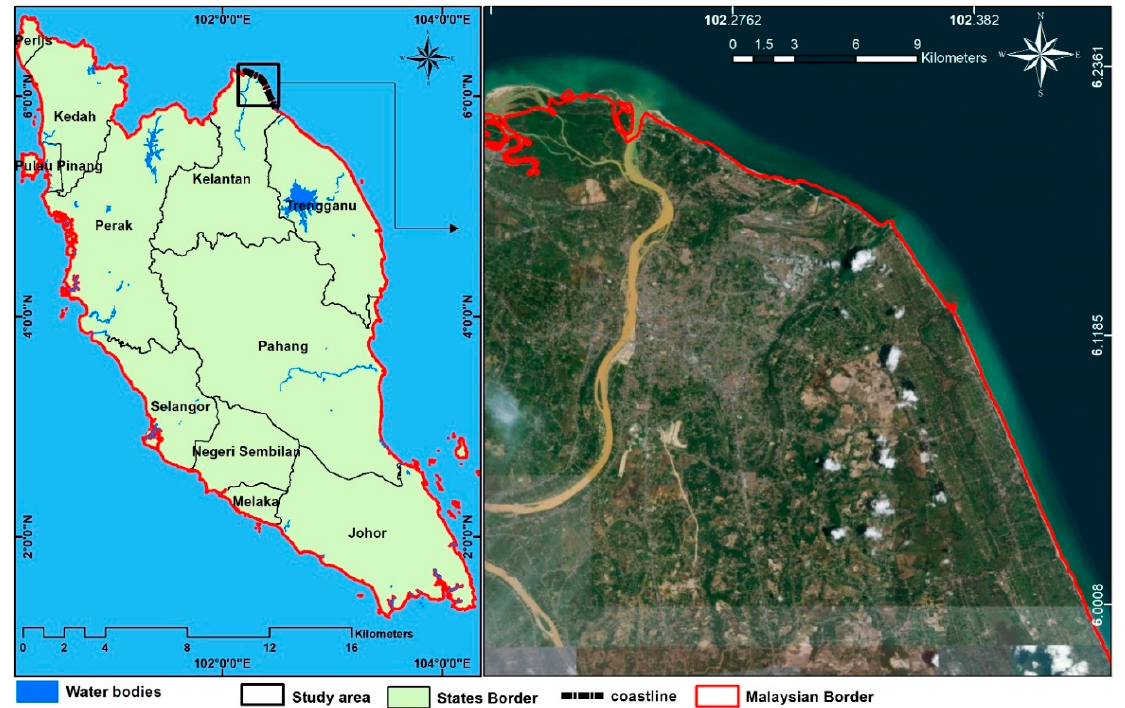
Figure 1. Geographical location of the study area in Malaysia.